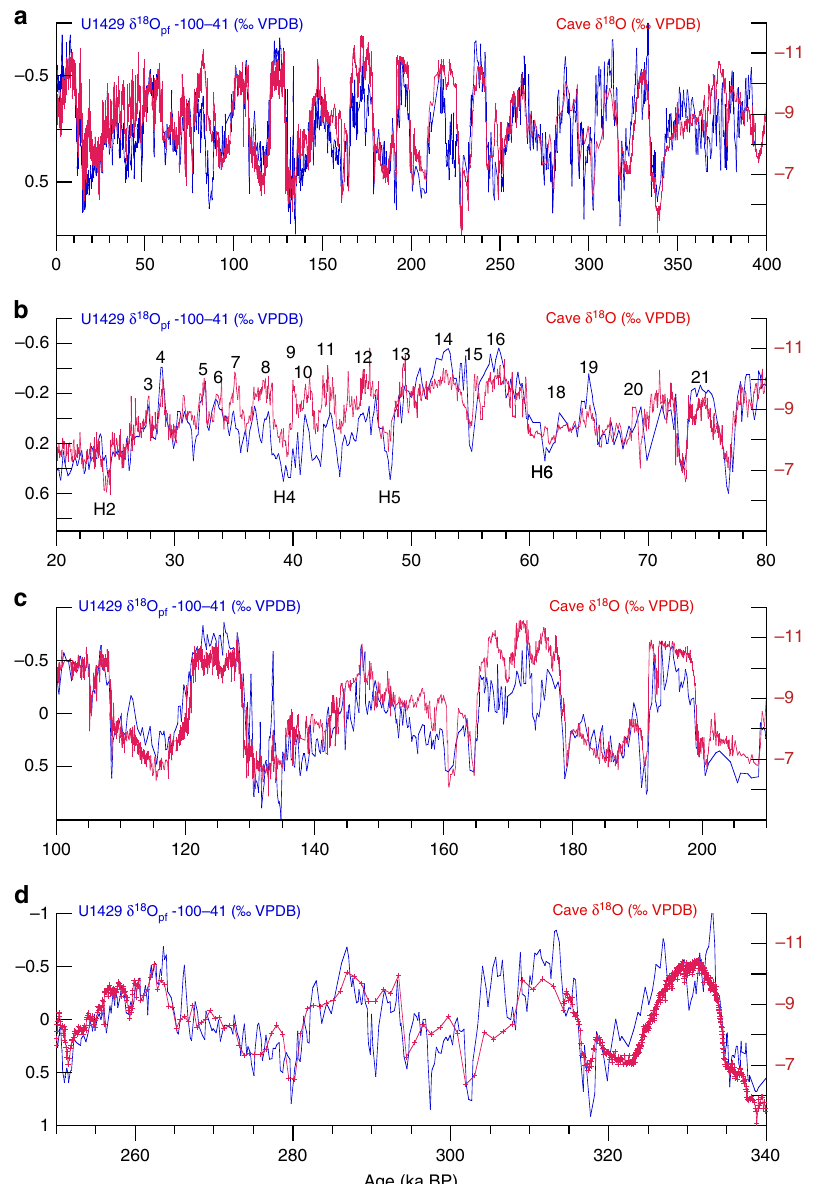
Fig. 3 Millennial-scale structure in notched δ 18 O pf compared to δ 18 O cave . a Notched U1429 δ 18 O pf on the cave-based age model. b Expanded 20 – 80 ka interval with millennial-scale Dansgaard – Oeschger (DO) and Heinrich events numbered. c Expanded 100 – 210 ka interval. d Expanded 250 – 340 ka interval showing structure not previously resolved in δ 18 O